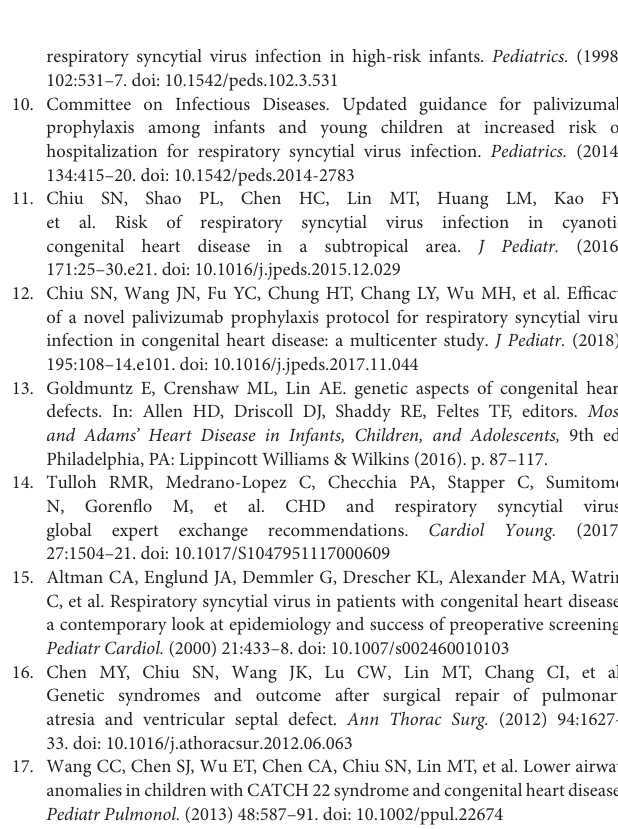
Supplementary Table 2 | Mean numbers of doses of palivizumab administered to patients with CHD according to their associated abnormalities. All comparisons showed no statistically significant